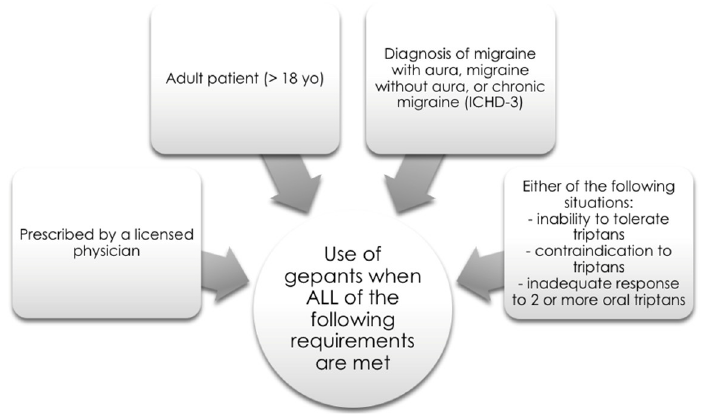
Figure 1. Criteria for starting an acute treatment with gepants. ICHD-3: International Classification of Headache Disorders, 3rd edition.